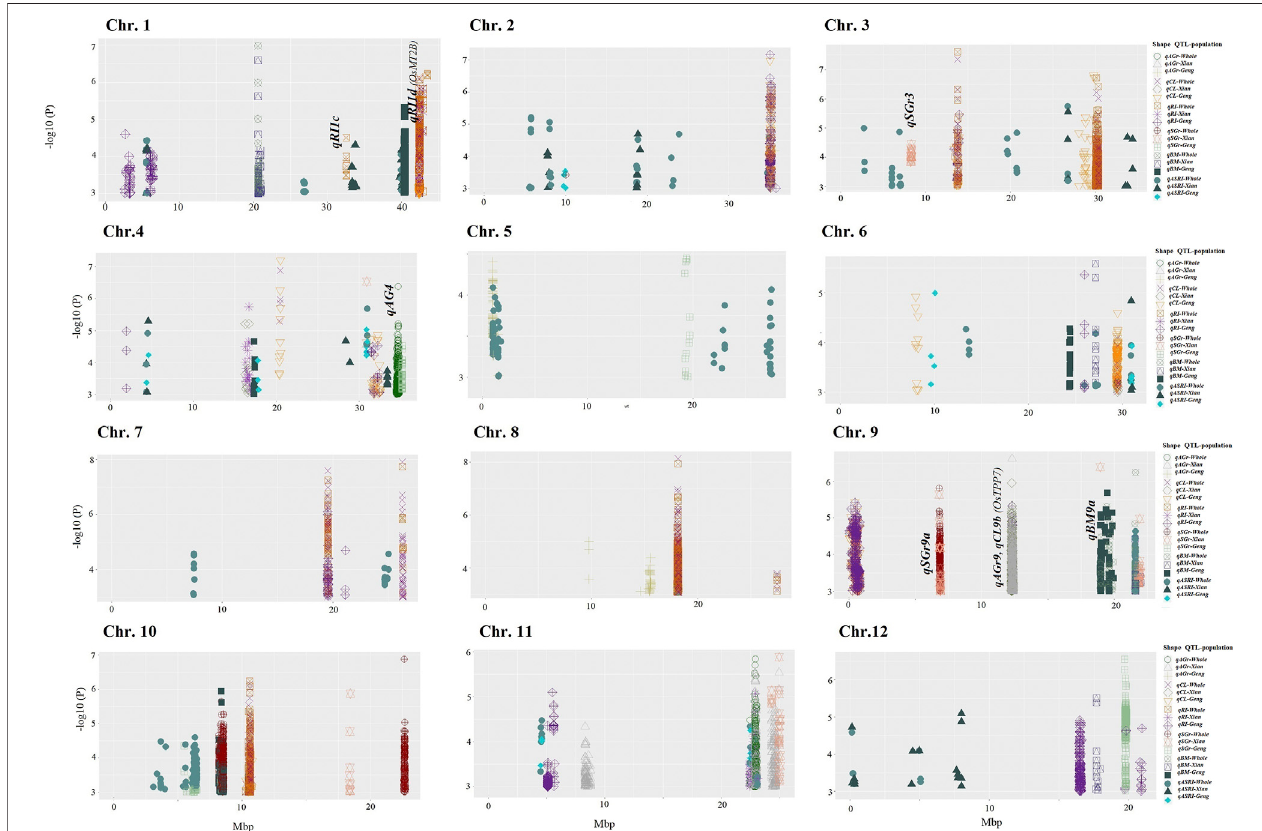
FIGURE 2 | Manhattan plots of AGT and SGT QTLs in the whole genome. Signi fi cant SNPs for six traits in Xian ( Indica ), Geng (Japonica ), or whole populations are displayed in different colors and shapes; each shape represents speci fi c QTL identi fi ed in Xian ( Indica ), Geng ( Japonica ), or whole.